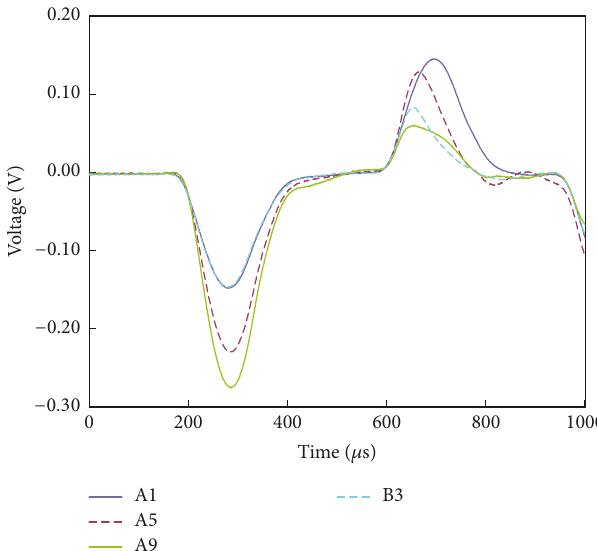
Figure 4: Typical waveform of the blocking impact test.